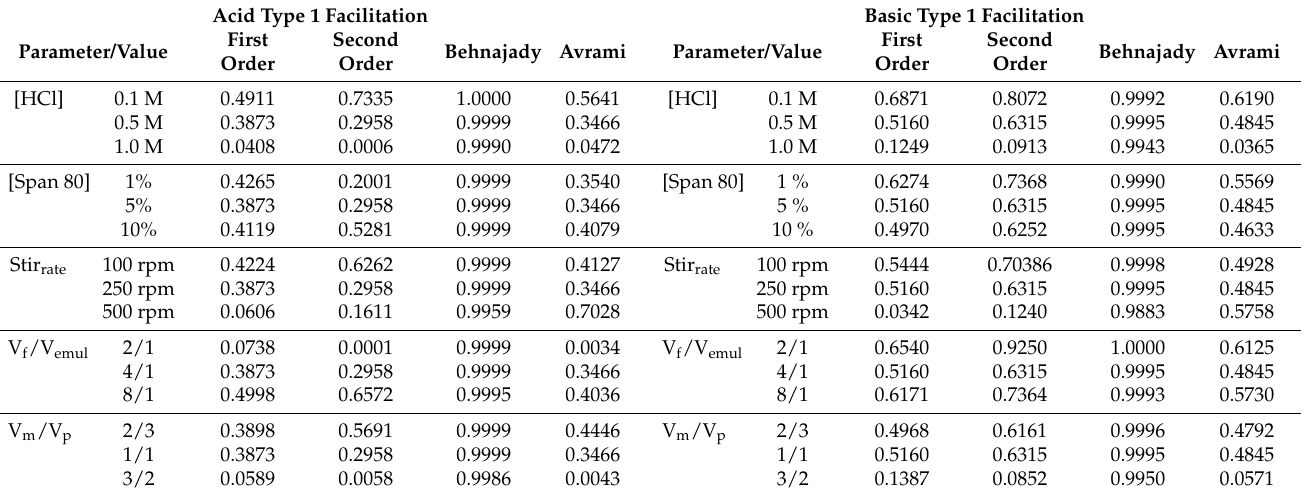
Table 1. Determination coefficients (R 2 ) of the fit of the different experimental parameters to the studied kinetic models in the removal of 4AP by ELM using acid and basic type 1 facilitations.